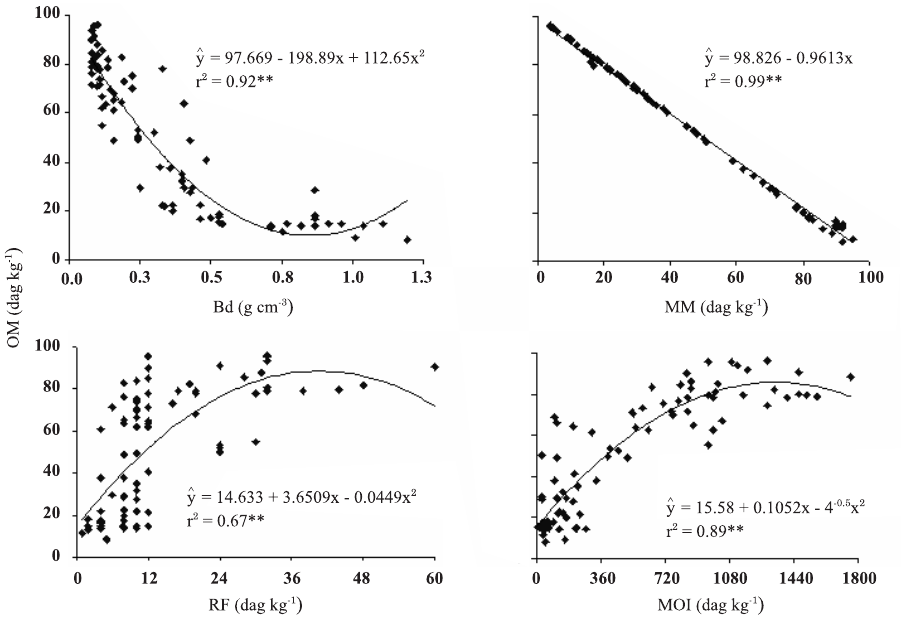
Figure 2. Content of organic matter (OM) in the peat bog and its relation with: bulk density (Bd); mineral material (MM); rubbed fibers (RF); moisture (Moi), and the respective regression equations and correlation coefficients in the peatland of the conservation unit Pau-de-Fruta, Diamantina,